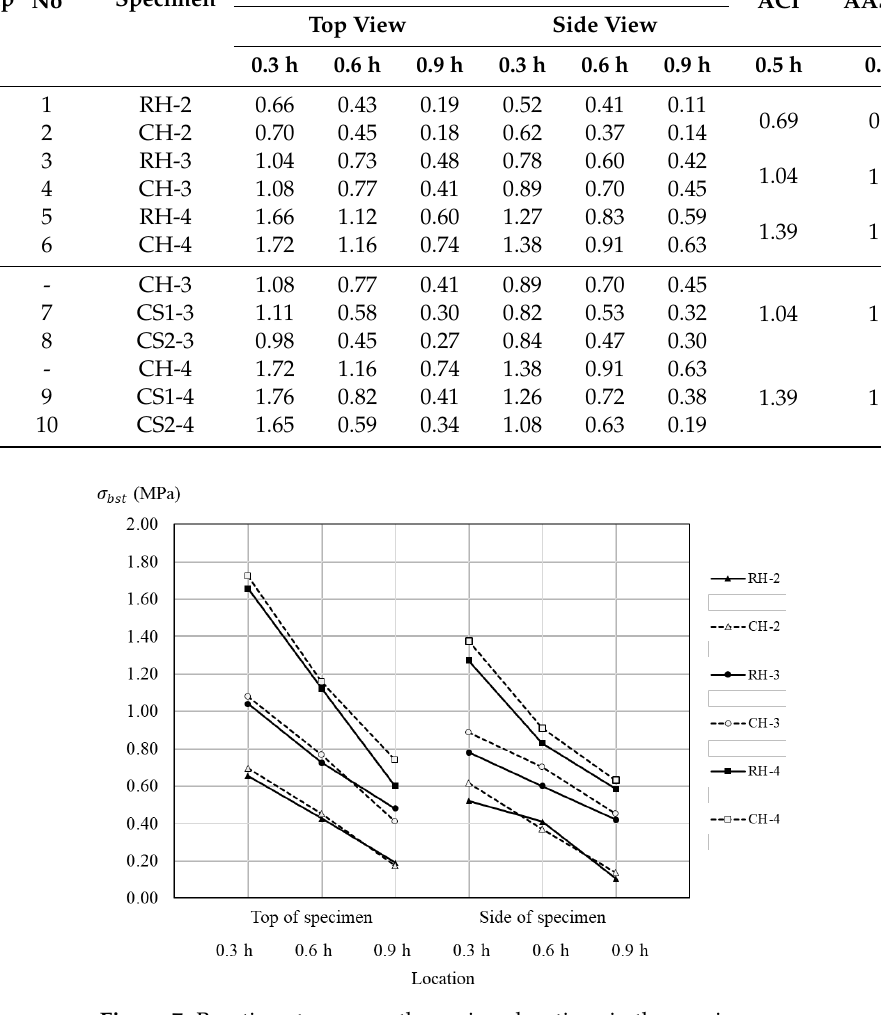
Figure 7. Bursting stresses on the various locations in the specimens.